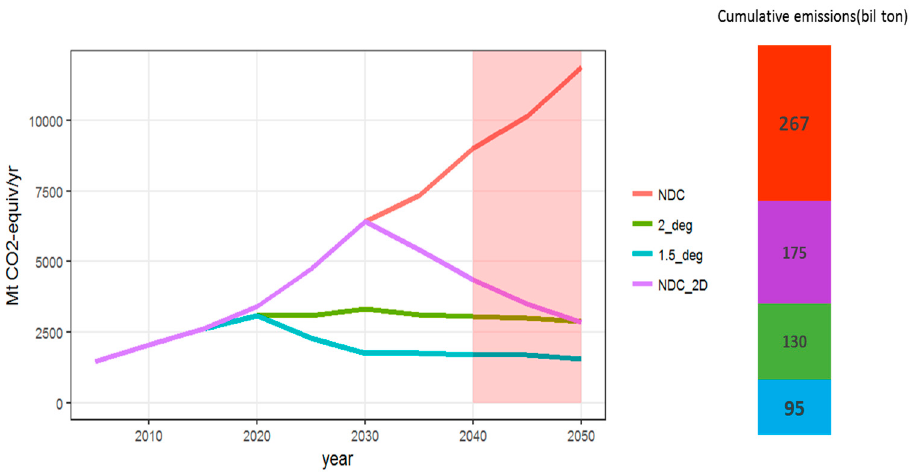
Figure 1. Annual greenhouse gas (GHG) emissions and cumulative GHG from 2005 to 2050 (billion tons CO 2 eq) across different scenarios.